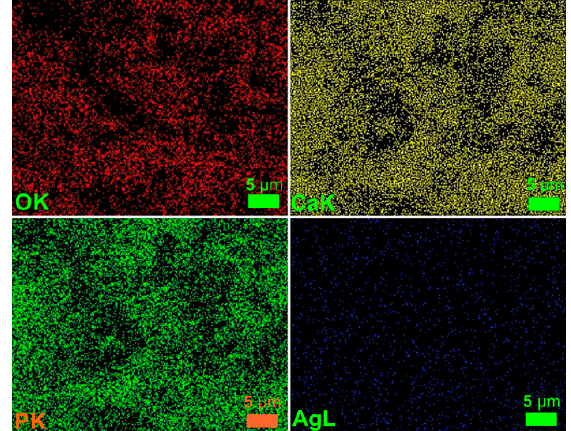
Figure 3. Elemental mapping of Ag:HAP thin film.